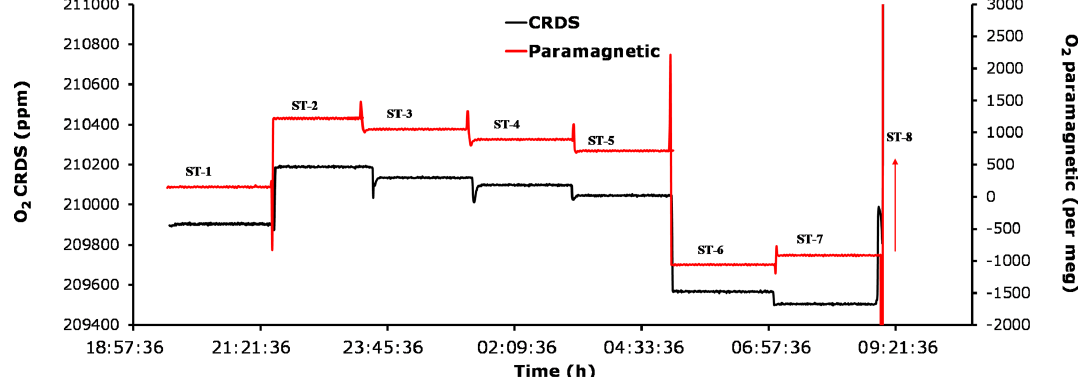
Figure 12. Comparison of oxygen mixing ratios for the seven standard gases measured using the CRDS analyzer (black) and the paramagnetic sensors